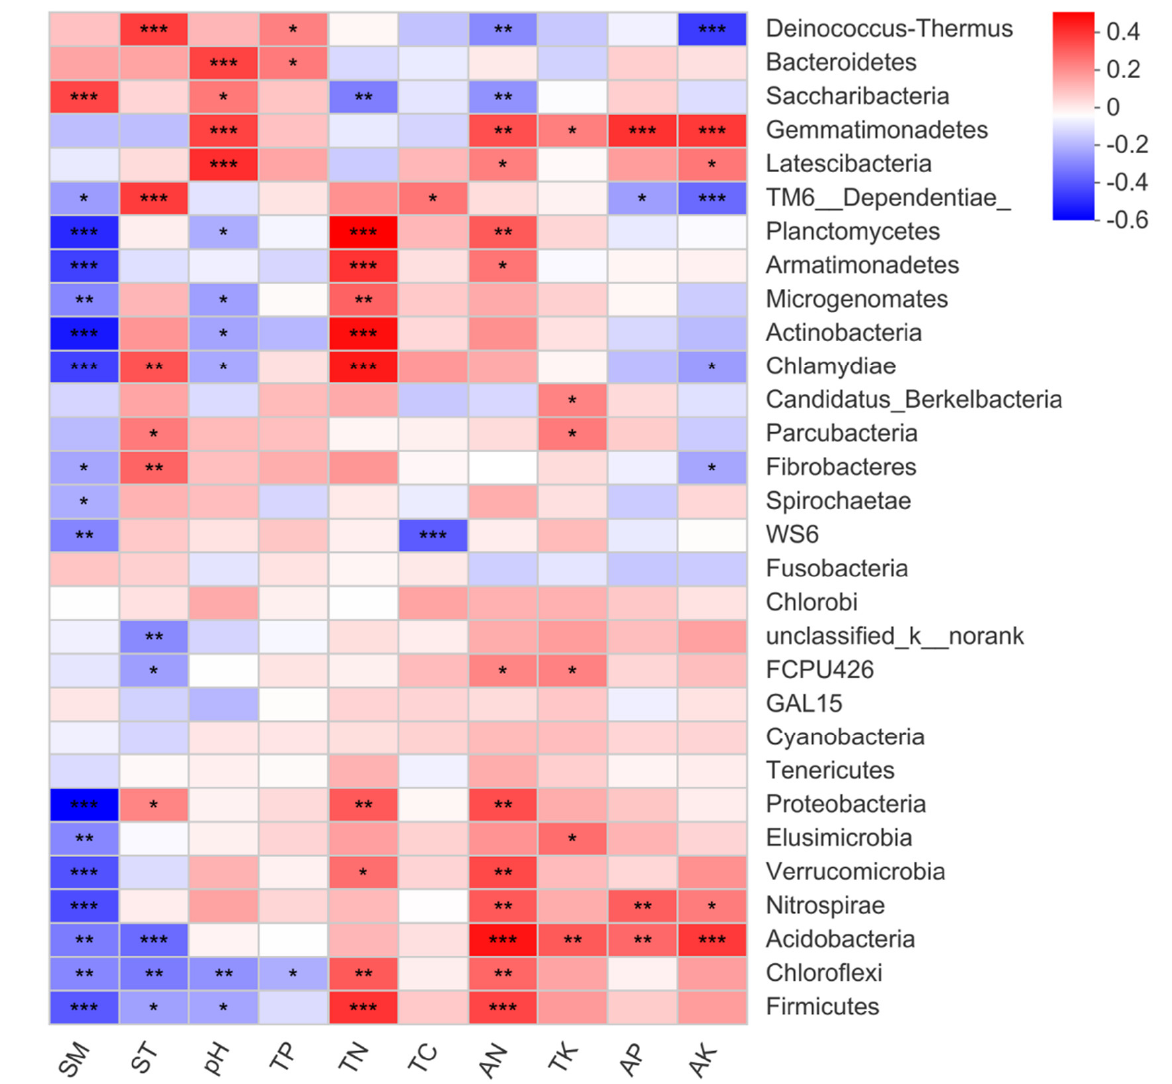
Figure 8. Heatmap of correlation between soil microorganisms and environmental factors at phylum level. Different colors in the figure represent different correlations between environmental factors and microorganisms; red represents positive correlation, blue represents negative correlation. * represents p < 0.05, ** represents p < 0.01, *** represents p < 0.001. SM represents soil moisture; ST represents soil temperature; pH represents soil pH value; TP represents total phosphorus; TN represents total nitrogen; TC represents total carbon; AN represents alkali-hydrolyzed nitrogen; TK represents total potassium; AP represents available phosphorus; AK represents available potassium.